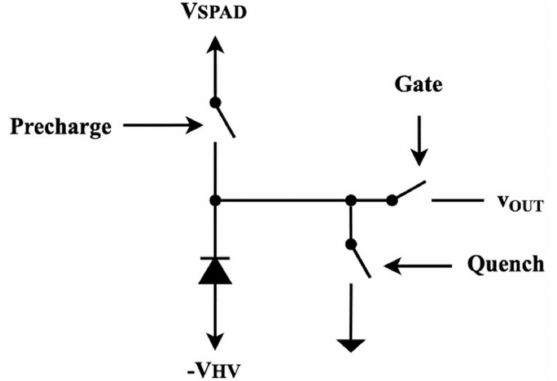
Figure 1. Conceptual schematic of time-gated SPAD